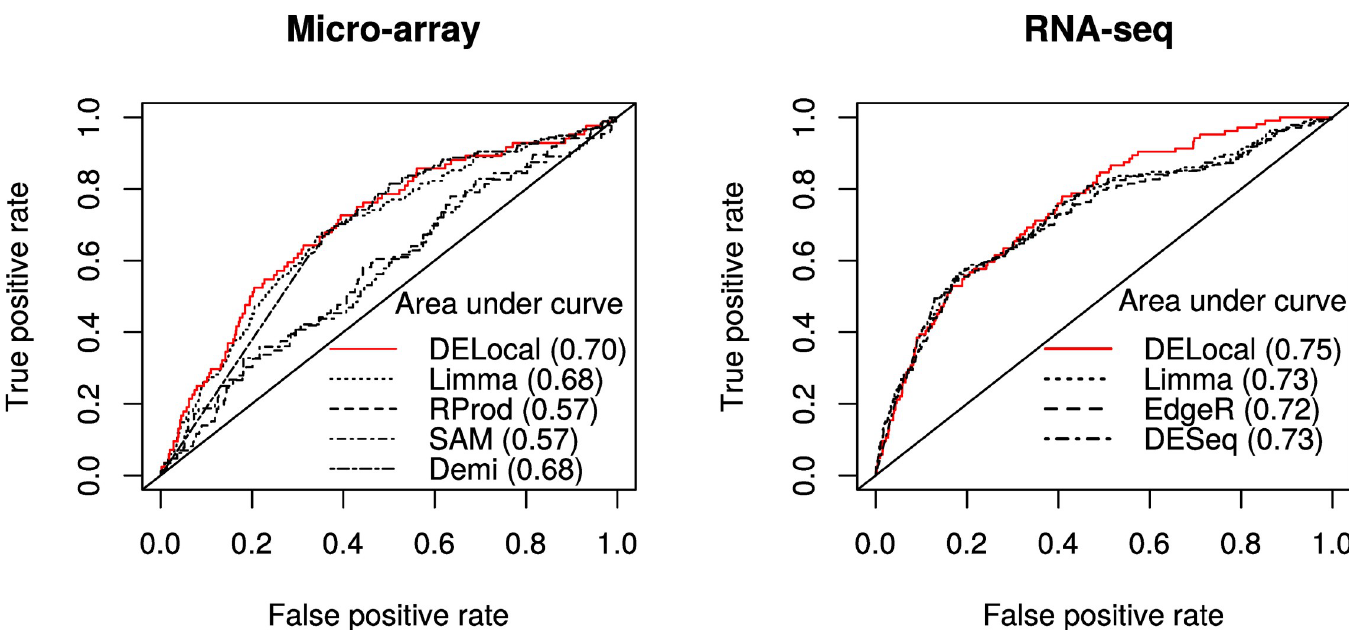
Fig 6. Compared to other methods, DELocal is at least as powerful in detecting differentially expressed genes. Receiver operating characteristic (ROC) curves and areas under the curves (within the parenthesis) show that DELocal outperforms other methods on both microarray and RNAseq